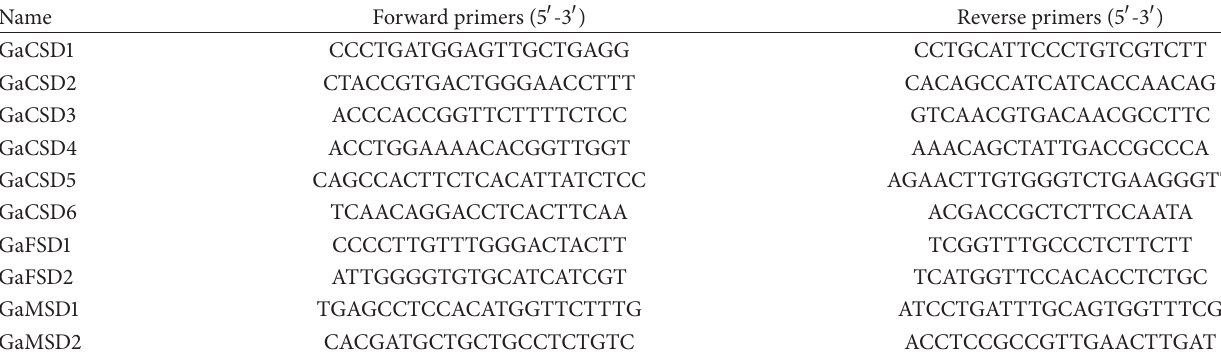
Table 1: List of primers used in quantitative real time PCR expression analysis.